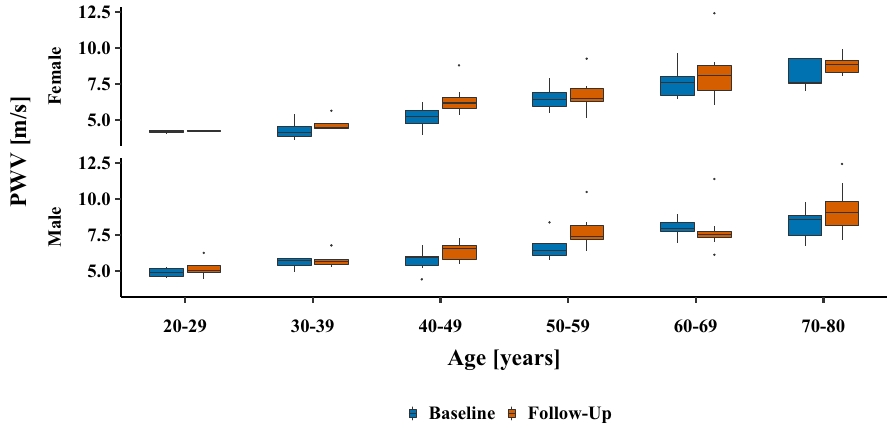
Figure 3. Progression of PWV after 6 years in the different decades. Blue box plots represent pulse wave velocities (PWV) in m/s at baseline, red box plots represent values six years later of the same study participants (lower and upper hinges correspond to the 25th and 75th percentiles). Please note that age on the x axis represents age of subjects at baseline. Values of females are given in the upper, those of males are given in the lower